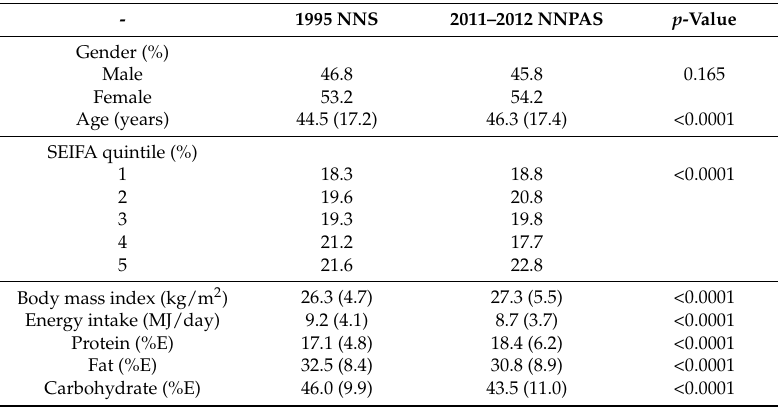
Table 1. Survey participant characteristics in 1995 and 2011–2012.